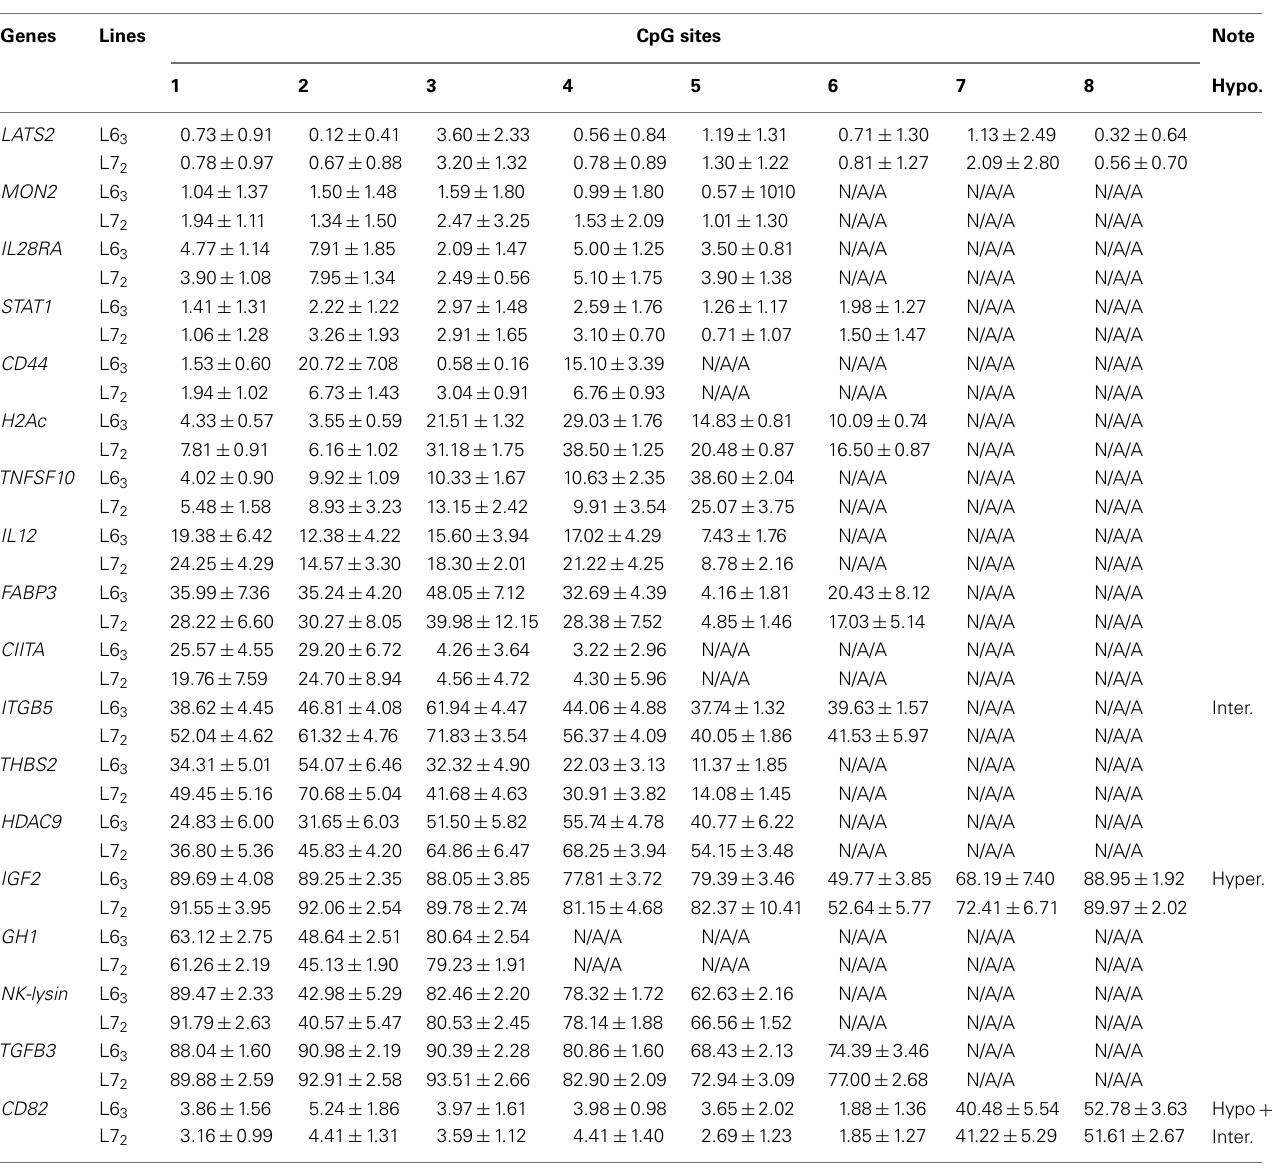
TableA3 | Promoter Methylation levels of L6 3 and L7 2 not challenged with MDV.